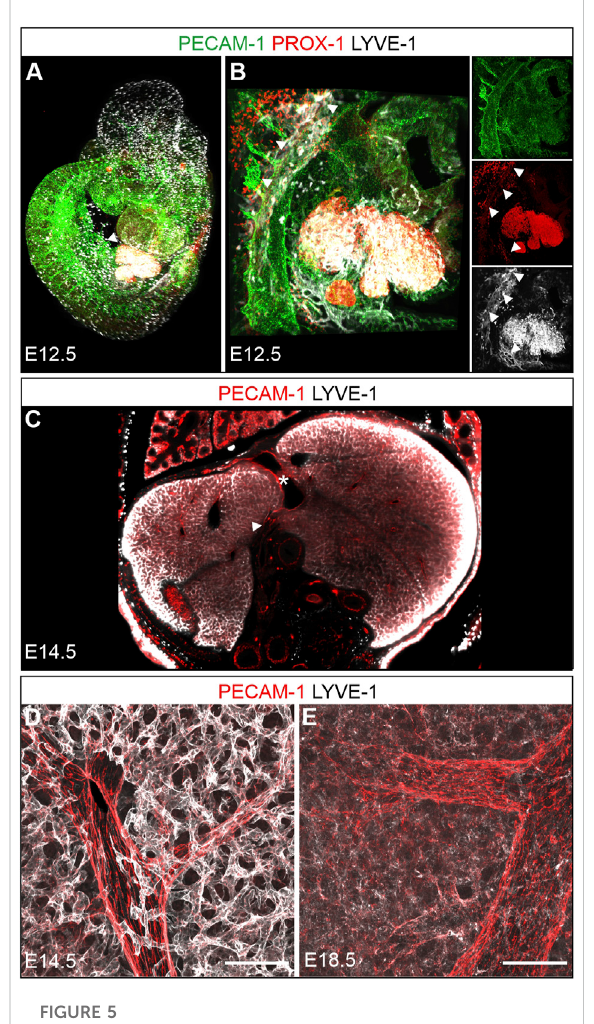
FIGURE 5 Prenatal development. A + B: 3D reconstruction of a whole mount immunostained wildtype fetus at E12.5 (overview A, developingliverB). (A) :ThedevelopinglivershowedintenseLYVE- 1andPROX-1 staining(arrowhead). (B) :Magni fi cationfromA, additional dorso-cranial and caudal vascular LYVE-1 and PROX-1 expression (arrowheads)indicated sitesof lymph vesselformation. (C) : Optical coronal section through an E14.5 fetus whole mount stainedforPECAM-1 andLYVE-1 revealedahomogenousnetwork of LYVE-1 positive sinusoids with PECAM-1 most prominent on larger vessels. The heterogenous antibody penetration results in enhancedsignalatthesamplemargins.Asterisk=ductusvenosus; arrowhead = portal vein. D + E: Vibratome sections (100 µm) from livers at E14.5 and E18.5 con fi rmed the dense, intensely LYVE-1 positive sinusoidal meshwork at E14.5 (D) and demonstrated a downregulation of LYVE-1 on hepatic sinusoids at E18.5 (E) , identical stainingconditionsas in (D) .LYVE-1 expressinglymphatic vessels next to portal vessels were not detected at either stage. Scale bars = 100 µm. (Figure 4F). Taken together, the observation of collecting vessels near the porta in various instances suggests a lymph fl ow following this hierarchical organization towards the porta hepatis.